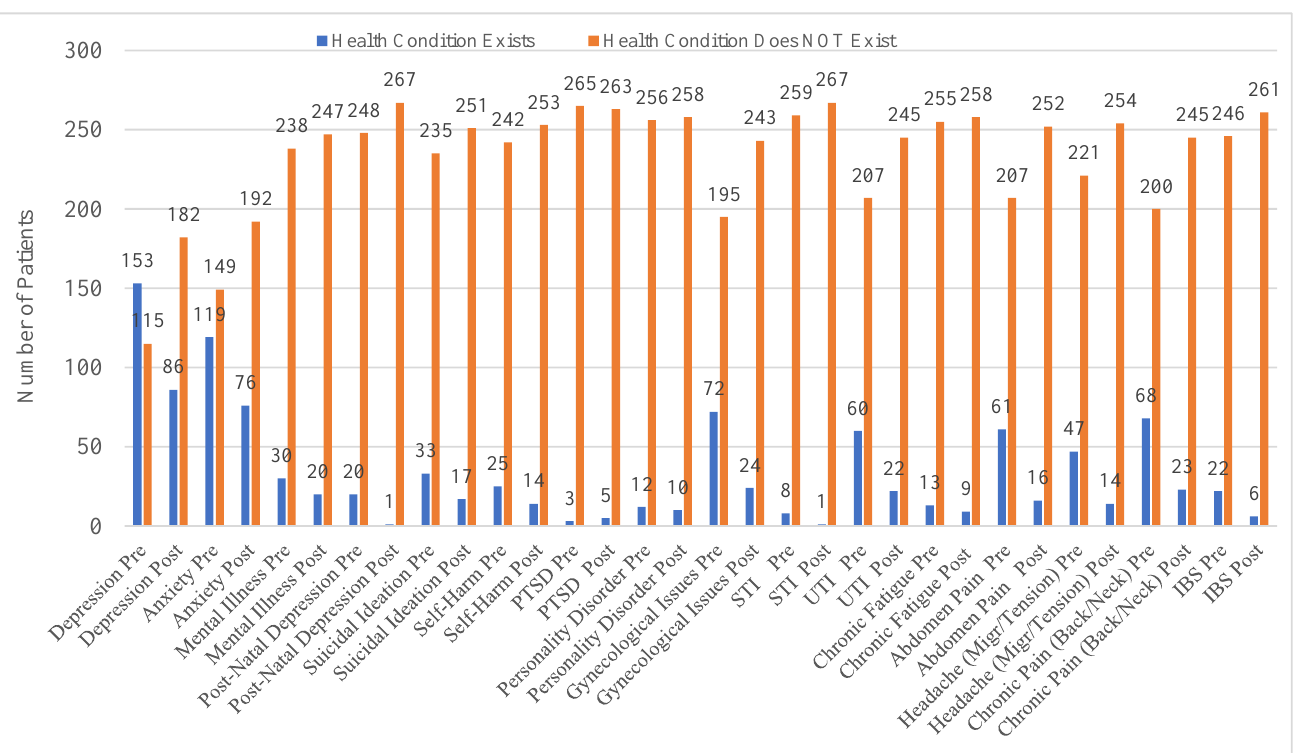
Figure 3. Recorded health conditions pre- and post-IRIS ( n = 268). (PTSD = post-traumatic stress disorder, UTI = urinary tract infection, STI = sexually transmitted infection, IBS = irritable bowel syndrome, Migr = migraine).